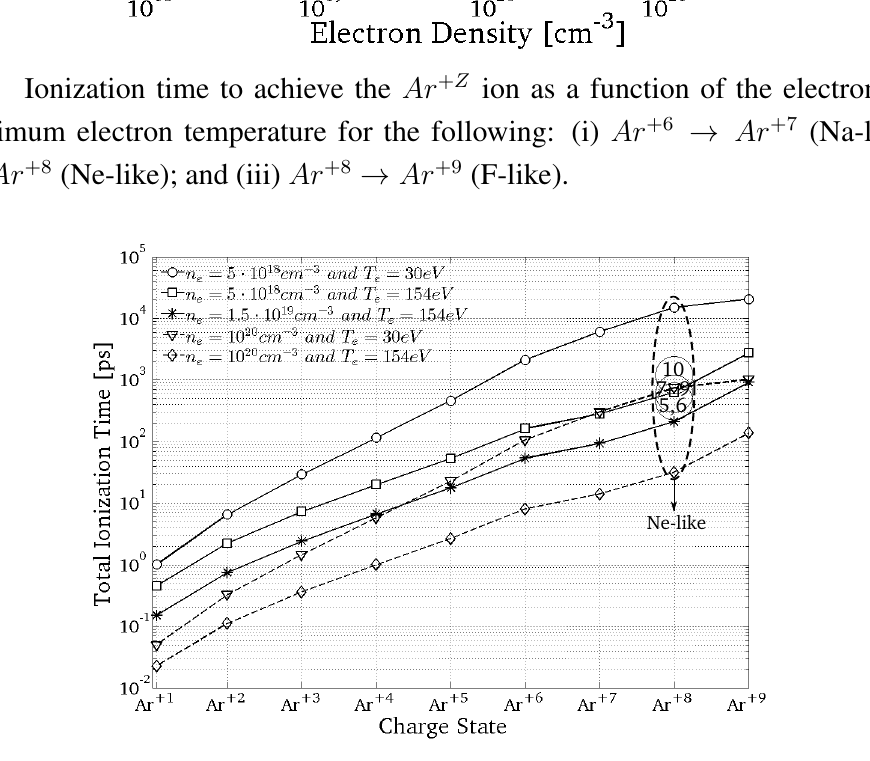
Figure 5. Total ionization time to reach different ionization stages ( Ar 0 → Ar + Z ) at different electron densities and temperatures. Namely, the dashed ellipse shows a range for the required total ionization time to achieve Ne-like Ar +8 at different electron densities and temperatures. Inside the ellipse, the pre-pulse durations or the time delay between pulses from the literature [5–10] are